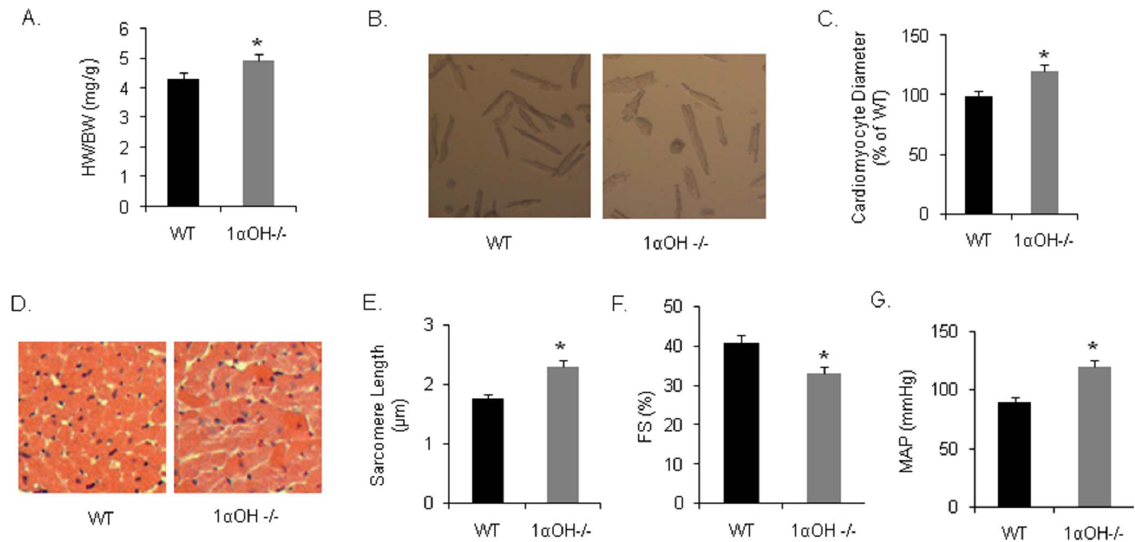
Figure 1. Physiological, echocardiographic, and hemodynamic parameters in 1 a OHase 2 / 2 mice at baseline: (A) Baseline HW/BW of 1 a -OHase 2 / 2 mice. *, p , 0.05 compared to WT. N=8–10. (B and C) Isolated adult CMs from 1 a -OHase 2 / 2 mice showing increased surface area compared to WT CMs. *, p , 0.05 compared to WT. N=8–10. (D) Cross sectional area of mice heart showing CM surface area. (E) Resting sarcomere length of 1 a -OHase 2 / 2 and WT CMs. *, p , 0.05 compared to WT. N=8–10. (F) Baseline fractional shortening (FS) of WT and KO mice. *, p , 0.05 compared to WT. N=8–10. (G) MAP of WT and 1 a -OHase 2 / 2 mice at baseline. *, p , 0.05 compared to WT. N=8–10.